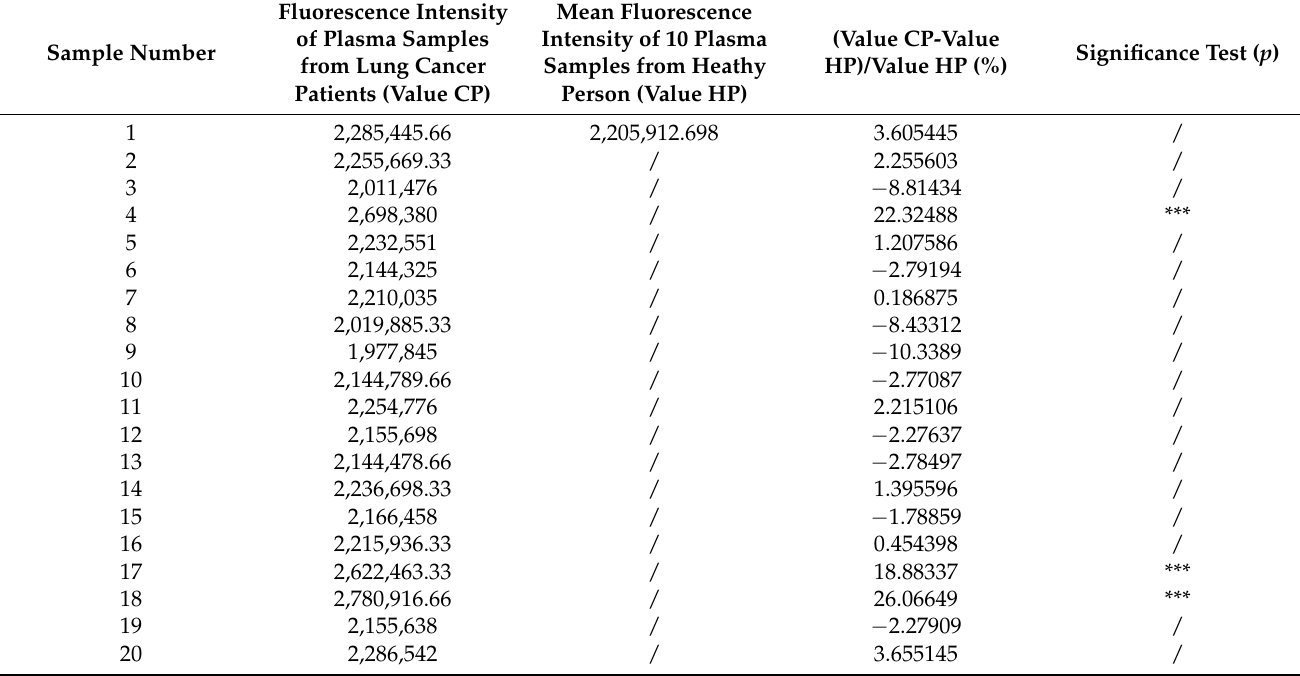
Table 3. The detection results of EGFR exon 20 mutations from the clinical